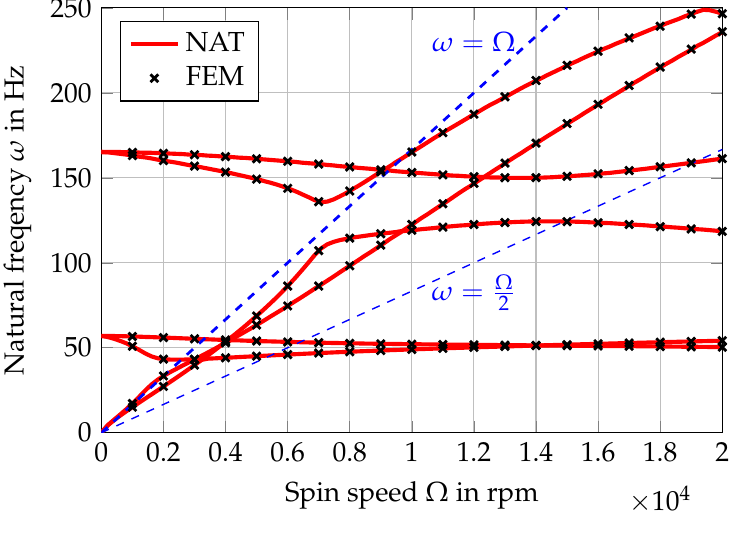
Figure 5. Campbell Diagram. Table 2. Flexural critical speeds in